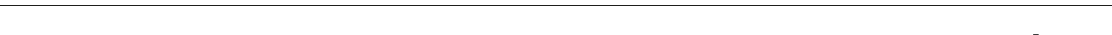
Fig. 6 E. coli could be internalized into neurons, dependent on IbeA – Caspr1 interaction. a Neonatal rats were subcutaneously injected with 1 × 10 5 CFUs of E. coli . After 18 h, the brains of rats with positive CSF were sectioned and stained with E. coli (Green) and CD31 (Red). DAPI was used to identify nuclei (blue). Arrows indicated E. coli in the brain parenchyma (4 ± 1.2 bacteria/slice, 27 slices from 9 rats from three independent experiments). Scale, 100 μ m. Images are representative of three independent experiments. b Primary cultured rat hippocampal neurons were infected with wild-type E. coli (E44), and then the cells were subjected to transmission electron microscopy (TEM) analysis. Images are representative of three independent experiments . E : E. coli , Nu: nuclear. Scale bar: 1 μ m. c Primary cultured rat hippocampal neurons were infected with E44 and ibeA -deleted ZD1 strain, respectively. Then the cells were subjected to quantitative TEM analysis. The percentage of neurons with internalized E. coli were calculated as neurons containing bacteria divided by total neurons in the fi eld of vision. Values are mean ± SD from three independent experiments. *** P < 0.001, Student ’ s t -test. d Bacterial invasion assay was performed using primary rat hippocampal neurons (2 × 10 5 cells/well) infected with E44 or ZD1, with various MOI as indicated. Values are mean ± SD from three independent experiments. *** P < 0.001, Student ’ s t -test. e , f Primary hippocampal neurons derived from Caspr1 loxP/loxP mice were transfected with Cre-expressing vector to ablate Caspr1 expression in neurons, with empty vector as control. The expression of Caspr1 was examined by immunostaining ( e ) and western blot (bottom panel, f ). Full blots are shown in Supplementary Fig. 8. Images are representative of three independent experiments. Scale, 100 μ m. Then E. coli invasion assay with Caspr1-suppressed neurons were performed (top panel, f ). Values are mean ± SD from three independent experiments. ** P < 0.01, Student ’ s t -test. g Transgenic mice carrying a targeted deletion of the 203 – 355 domain of Caspr1 were generated, and then